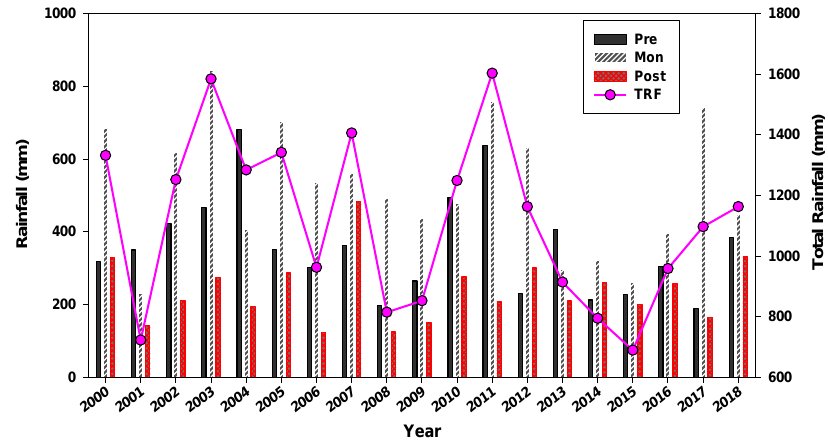
Figure 2. Inter-annual rainfall patterns (mm) in the premonsoon (Pre), monsoon (Mon), and postmonsoon (Post) seasons during 2000–2018. TRF: Total rainfall.